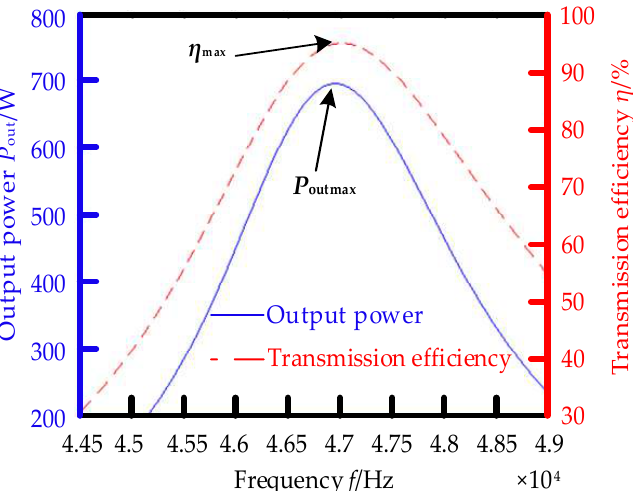
Figure 4. Relation curve of system frequency with transmission efficiency and output power when there is no frequency splitting.